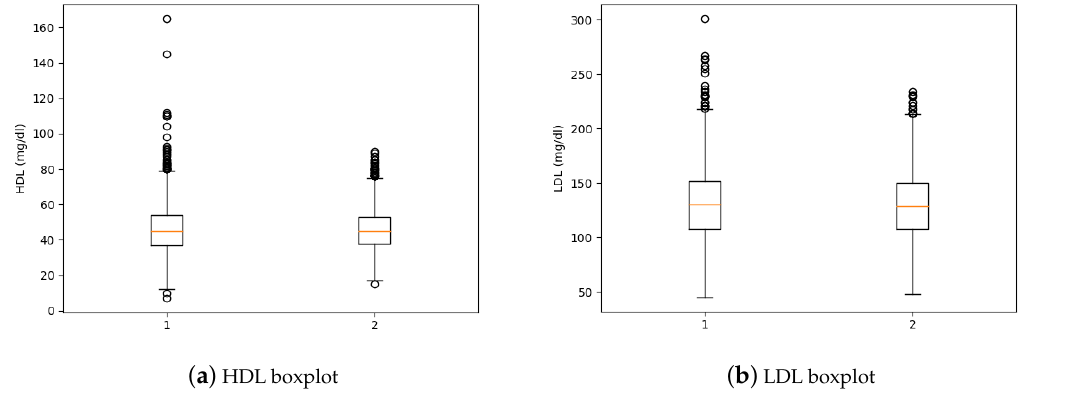
Figure 4. HDL and LDL Boxplots.